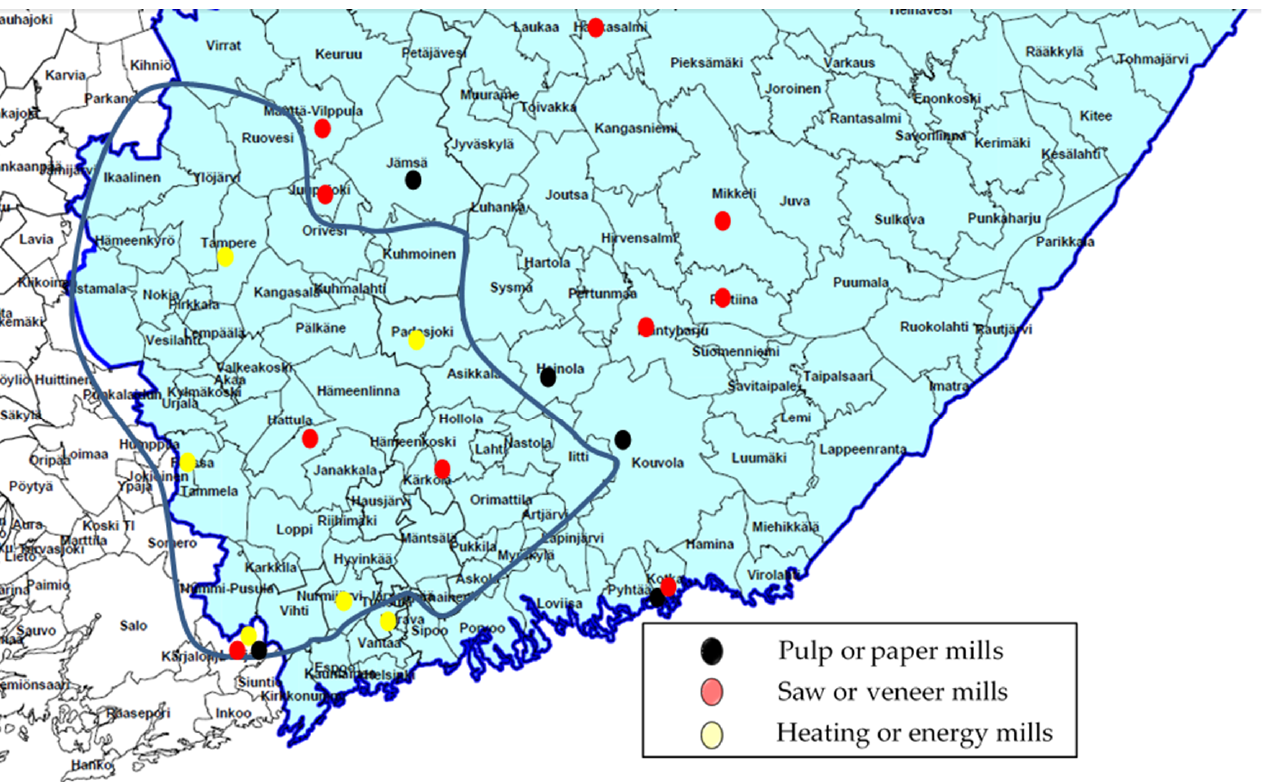
Figure 2. Wood-procurement area (inside blue line) and mills of the material and energy industry.